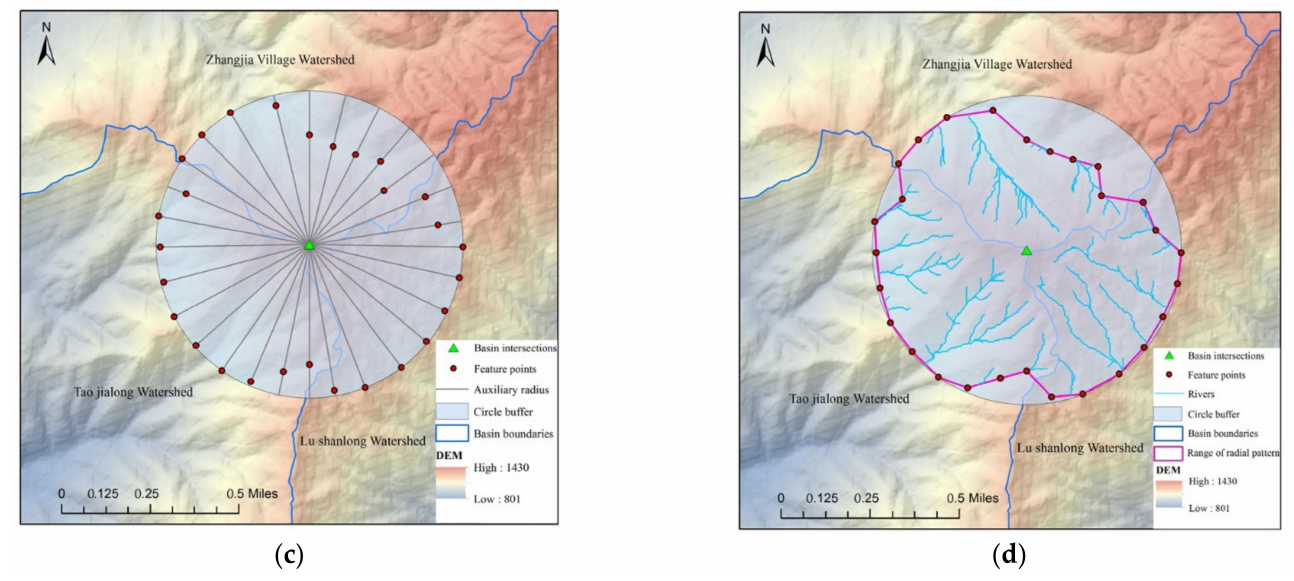
Figure 13. Determination of the RD scope. ( a ) Auxiliary radii and PSs of unit 3. ( b ) The RD scope of unit 3. ( c ) Auxiliary radii and PSs of unit 7. ( d ) The RD scope of unit 7.